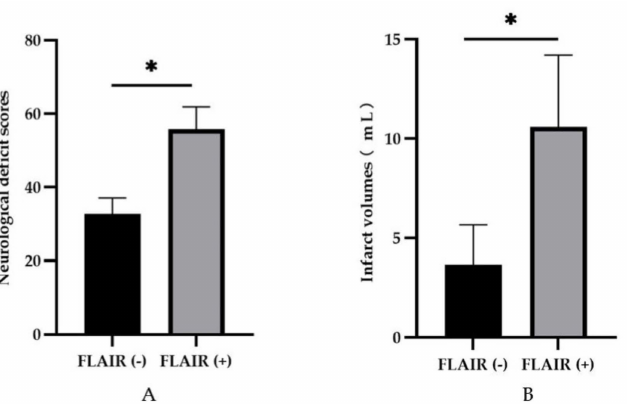
Figure 3. The FLAIR ( − ) group had lower neurological deficit scores and smaller infarct volumes than the FLAIR (+) group. * Presented p < 0.05. ( A ) The postoperative neurological deficit scores of the monkeys in each group 24 h after infarction. ( B ) The infarct volumes on DWI in each group.